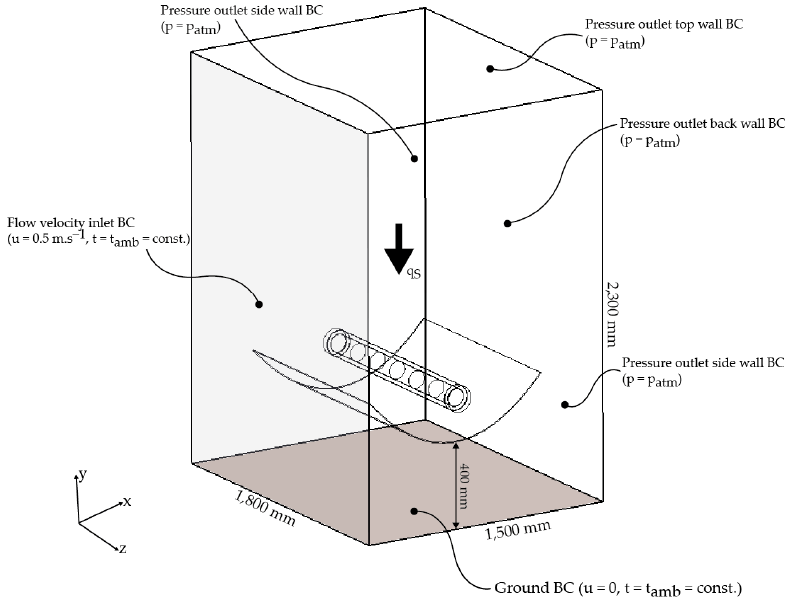
Figure 5. Computational domain and boundary conditions (BC).